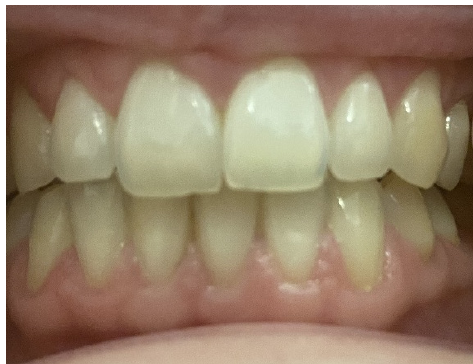
Figure 1. Clinical dental investigation of the